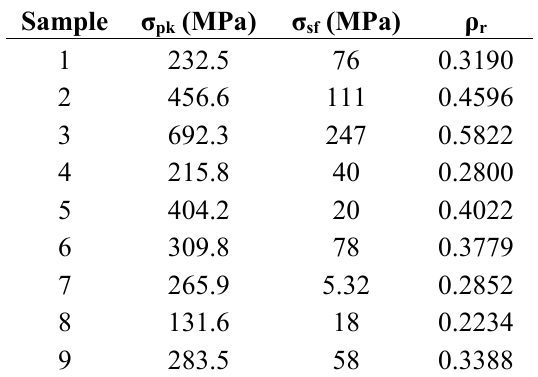
Table 4. Values of peak and collapse strength for the samples.